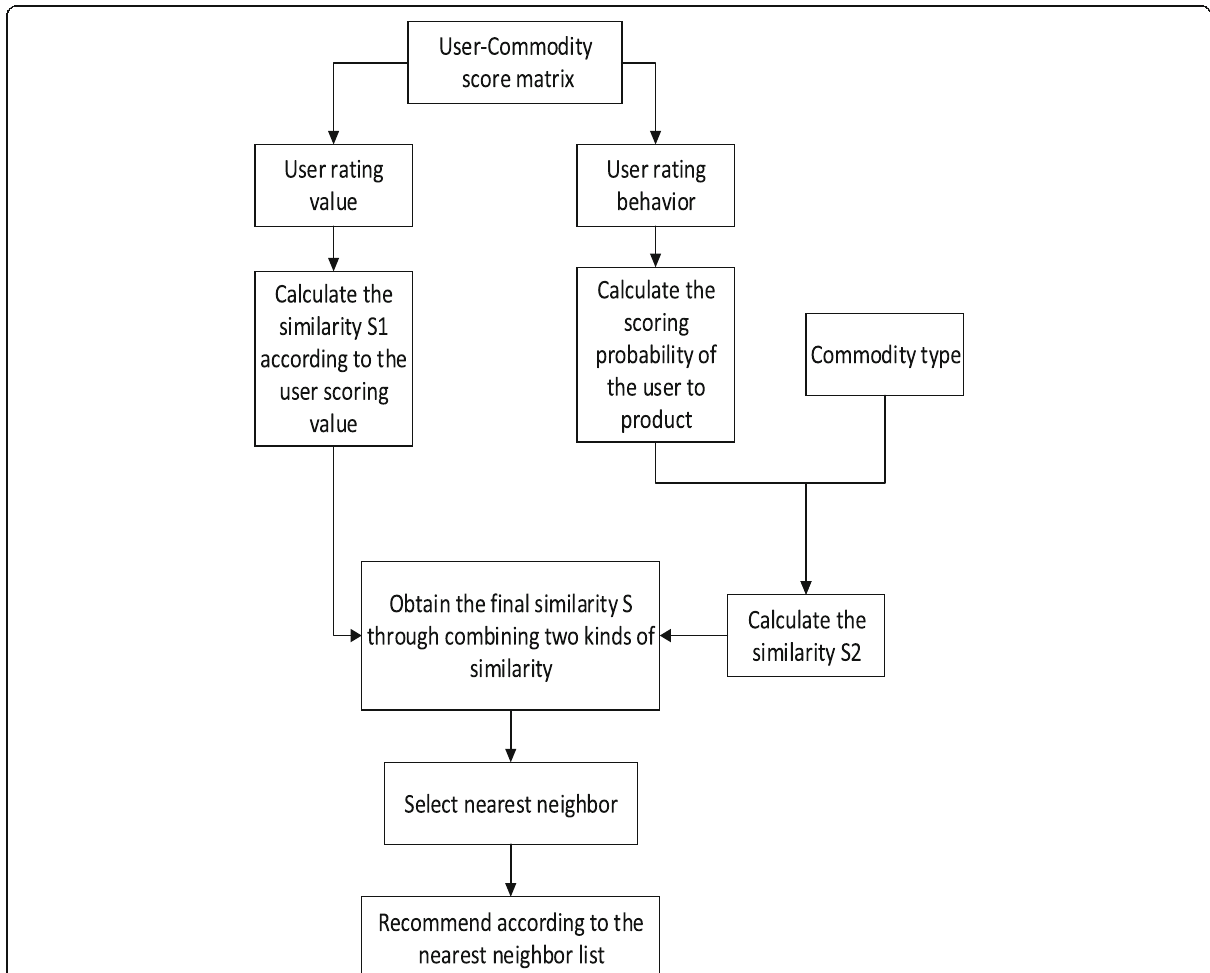
Fig. 3 Recommendation algorithm model of integrating score preference and project type. On the basis of the conventional algorithm based on neighborhood, the ideas of the user behavior in Fig. 1 and the improved similarity of Fig. 2 are integrated. The improved algorithm framework of this chapter is obtained, which is called the recommendation algorithm framework of scoring preference and project type. The core idea of the model of score preference and project types in Fig. 3: Firstly, we calculate the similarity S1 based on the matrix. Then, we calculate the possibility Pro of the user to score the product according to preference information implied in the user rating behavior. The second similarity S2 is calculated according to Pro and the type of the product. Due to the different weights of the two similarities, the final similarity of the user S is obtained by combining the two similarities S1 and